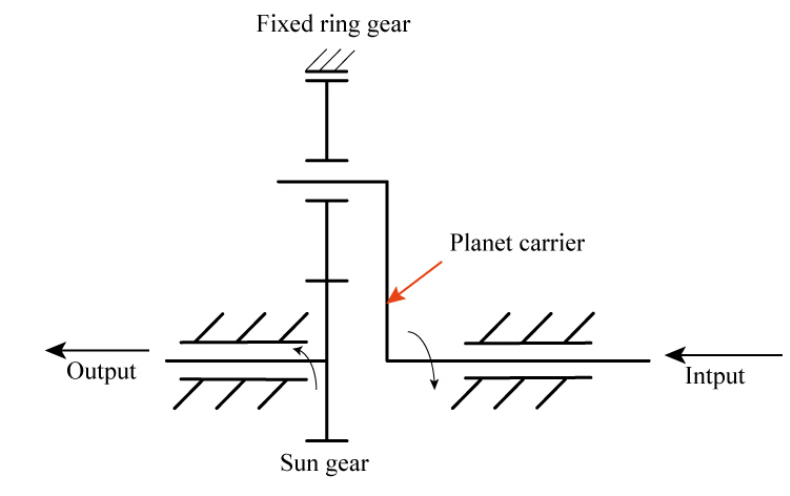
Figure 3. Kinematic schema of experiment planetary